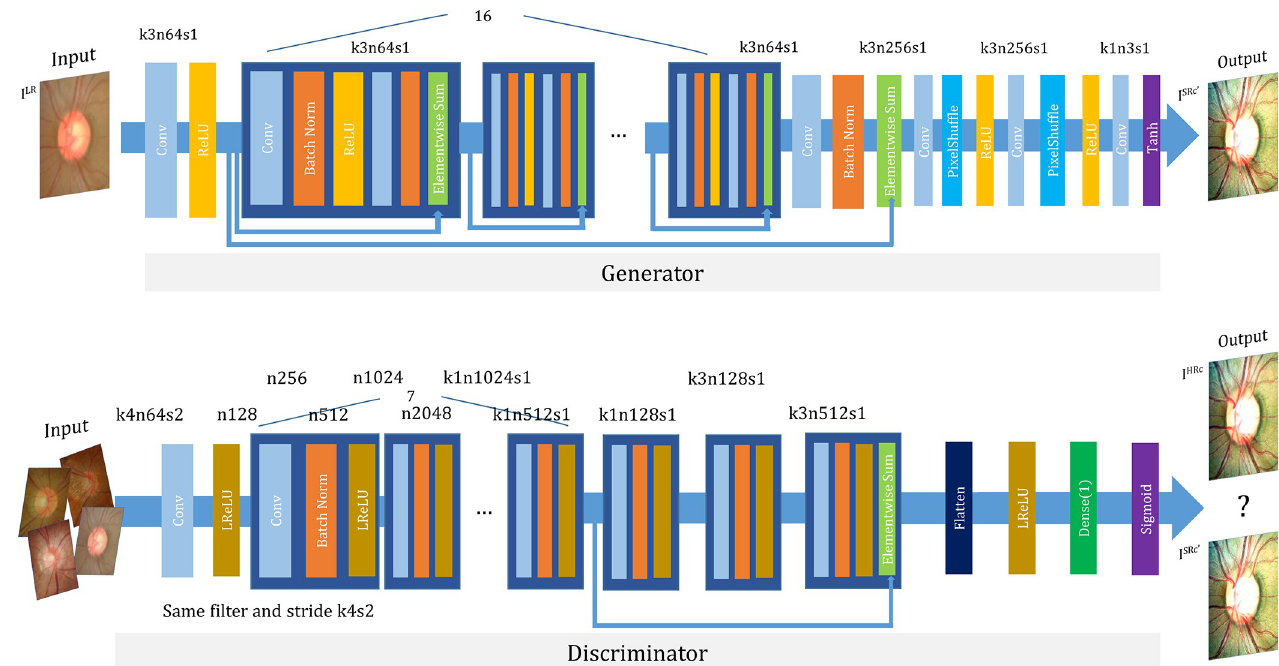
Fig 2. Architecture of generator and discriminator network. The corresponding kernel size (k), number of feature maps (n) and stride (s) are indicated for each convolutional layer.